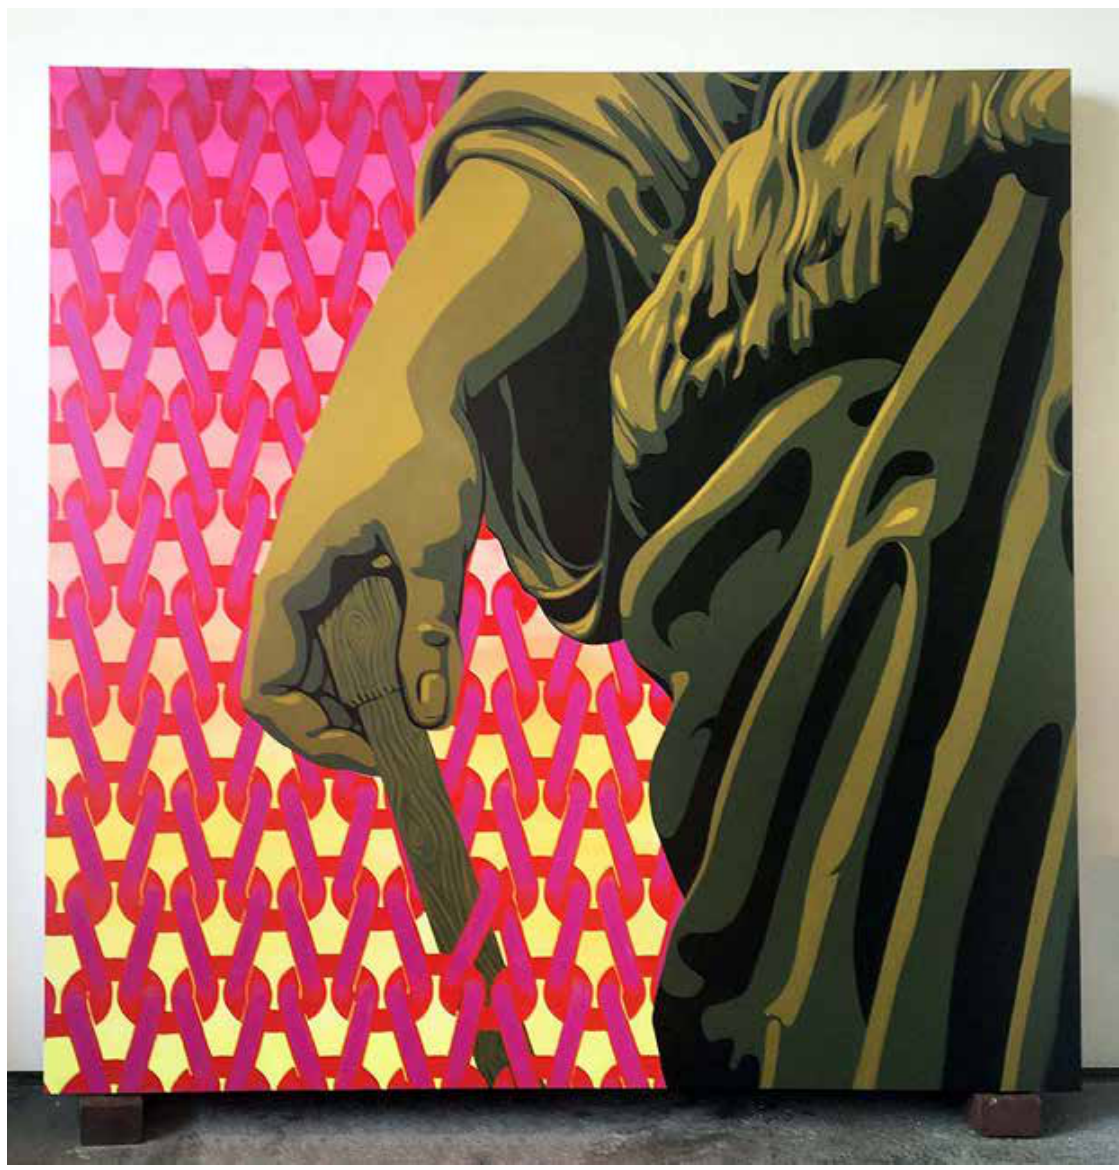
Figure 9: Jenny Roesel Ustick, Right Side, Wrong Side, 2018. Acrylic on canvas, 162.4 x 162.4